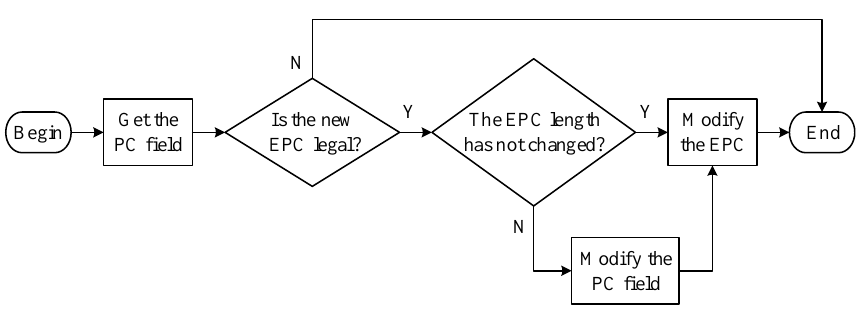
Figure 5. EPC Modification